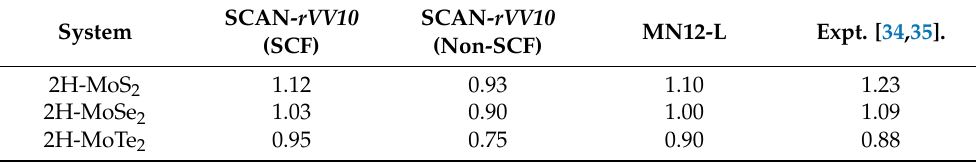
Figure 7. Comparison of the electronic band structures of bulk 2H-MoCh 2 (Ch = S, Se, Te), obtained using SCAN- rVV10 : ( a ) MoS 2 , ( b ) MoSe 2 , ( c ) MoTe 2 . The CBM and VBM band edges are marked by tiny circles in red and green, respectively. Bandgap values, E g , are indicated. The Fermi-level is referenced at 0.0 eV and is marked by a dotted line in red. The high-symmetry points along the wave vector axis considered were similar to that expected of the 2D layered 2H-MoCh 2 systems. The nature of bandgap transition did not change when high-symmetry points expected of bulks were used (see Figure S1 of Supplementary Materials). Table 4. Comparison computed bandgaps and HOMO–LUMO gap (eV) with experiment for MoCh 2 (Ch = S, Se, Te)